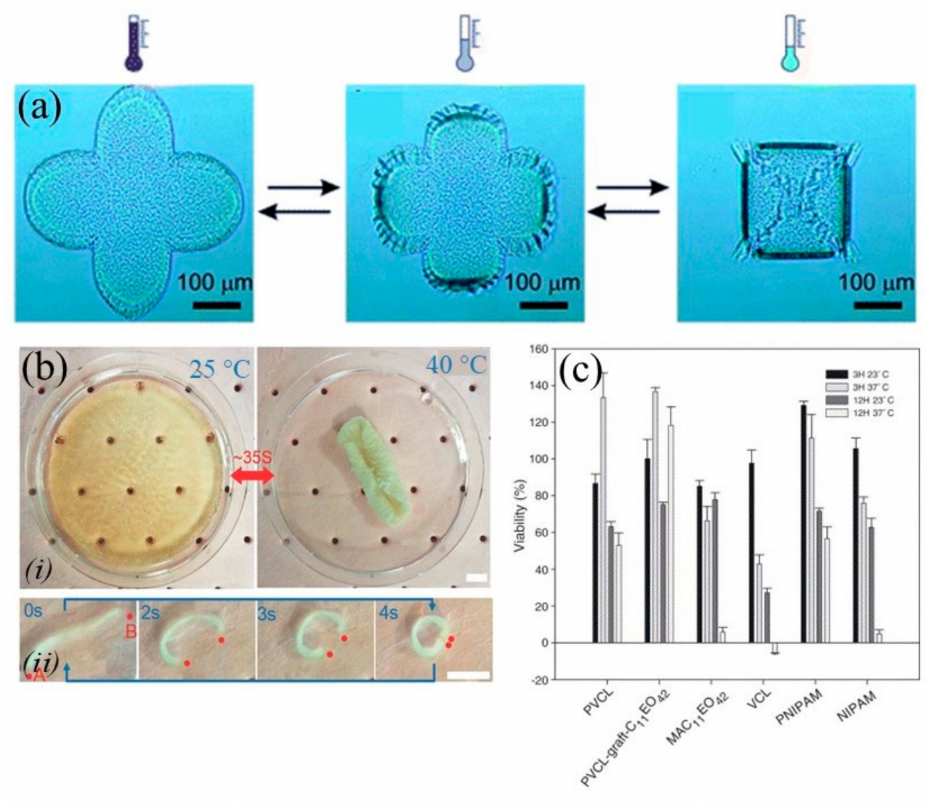
Figure 4. Temperature-responsive materials: ( a ) The polymer bilayer is undeformed at elevated temperatures when the poly-(NIPAM–ABP) layer is shrunk. Reprinted with permission [70] © 2020 The Royal Society of Chemistry. ( b ) Thermally triggered response of hydrogels: ( i ) Morphology of a gradient porous hydrogel at 25 and 40 ◦ C, ( ii ) Morphology and thermal responsive time of a gradient porous hydrogel strip after being put into 40 ◦ C H 2 O. Reprinted with permission [71] © 2020 John Wiley and Sons. ( c ) Viability values for the thermosensitive polymers and monomers. Reprinted with permission [80] © 2020 Elsevier. Table 2. Overview of the experiments on 4D (bio-)printing and other manufacturing approaches using temperature as a predefined stimulus.